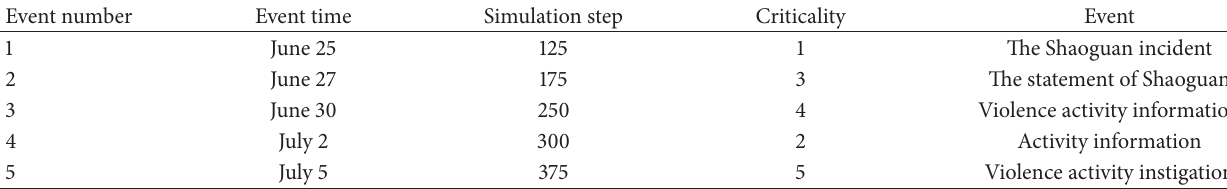
Figure 6: Randomness influence on the results (without strategy, single event). Table 5: Meta-events of the case